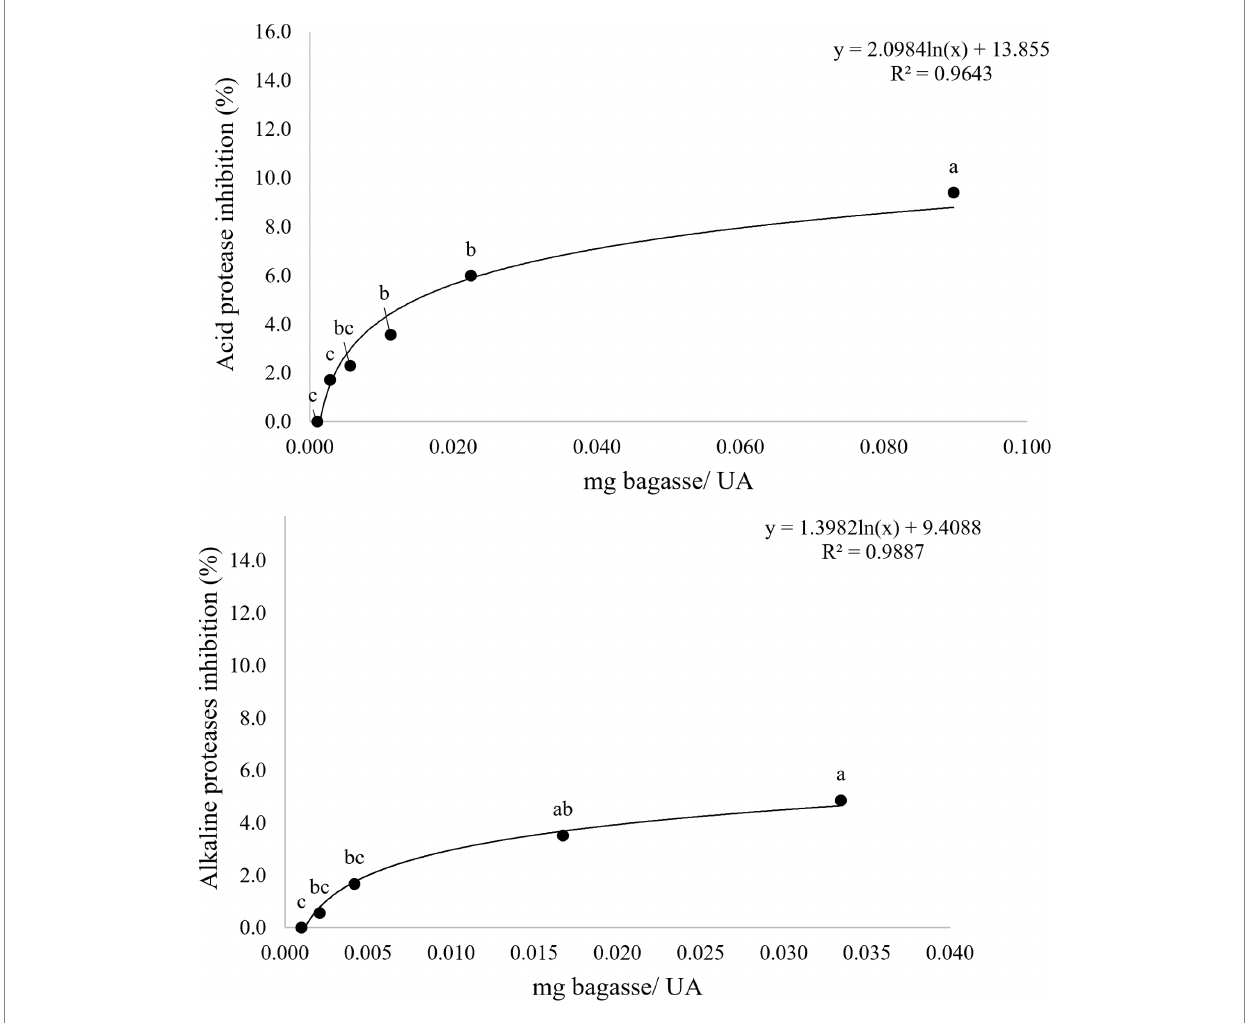
FIGURE 2 Inhibition curve of acid and alkaline protease activity obtained after 1 h incubation of digestive extracts of gilthead seabream in the presence of increasing concentrations of wine bagasse. Each point is the mean of three replicate measures. Points not sharing a common letter are statistically different with p <